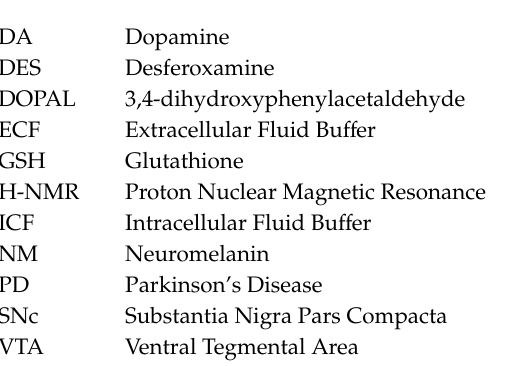
Figure S1: H-NMR spectra showing that the dominant species at the (A) beginning of the reaction is dopamine, and (B) still dopamine at the end of the reaction. (C) Overlay of the spectra in (A) and (B) demonstrating that the peaks match perfectly, Figure S2: Calcium does not contribute to dopamine (DA) melanization, Figure S3: The antioxidant GSH reduces dopamine melanogenesis in a concentration dependent